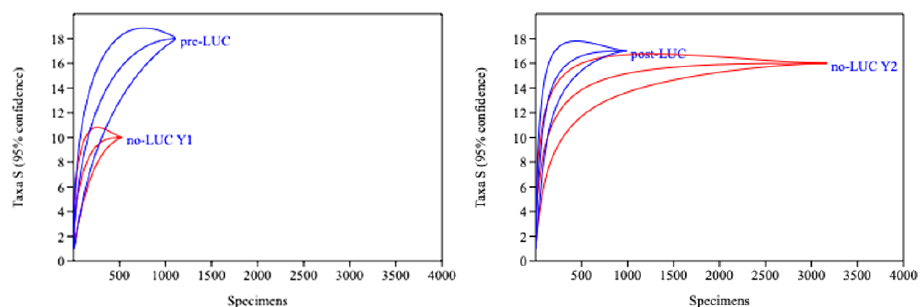
Figure 4. Individual-based taxon rarefaction curves, by year and area, that differentially estimate the relative importance of taxa richness change in composition of the arthropod community. Delimited area around the curves indicates 95% confidence interval.